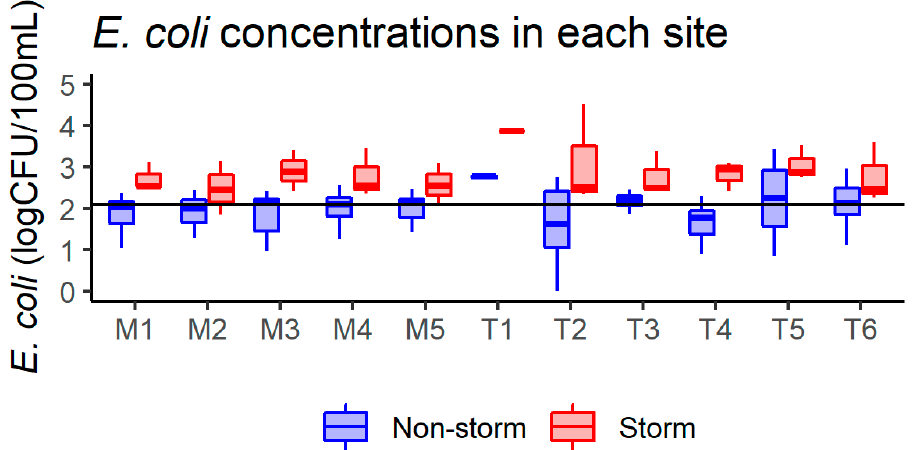
Figure 2. E. coli concentrations in a logarithmic scale for each site in this study. Red boxes indicate range of E. coli concentrations during storm events. Blue boxes indicate range of E. coli concentra- tions during non-storm events. The threshold of the rainfall amount for a storm event is 12.7 mm (0.5 inch) within 36 h. Black line denotes the geometric mean threshold of E. coli concentration of 126 CFU/100 mL (2.1 log10 CFU/100 mL). M indicates mainstem sites, whereas T indicates tributary sites of the sampling locations.